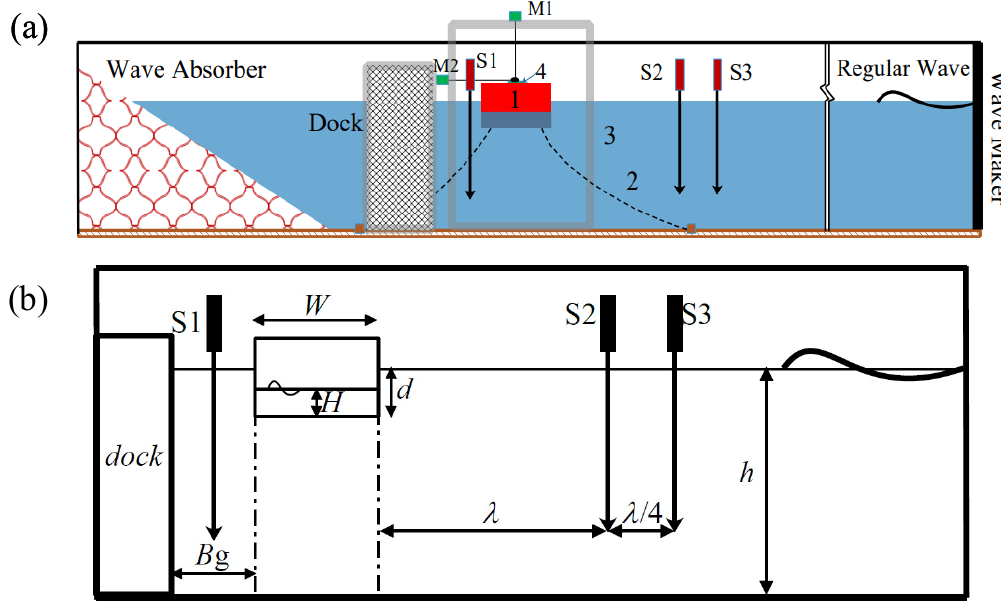
Figure 1. ( a ) The layout of the experimental wave tank; (1) floating box, (2) mooring line, (3) outer fixed frame, (4) inclination sensor, (M1/2) Displacement sensors, (S1/2/3) Wave probes; ( b ) Parameter setup of the experimental model, λ is wave length.